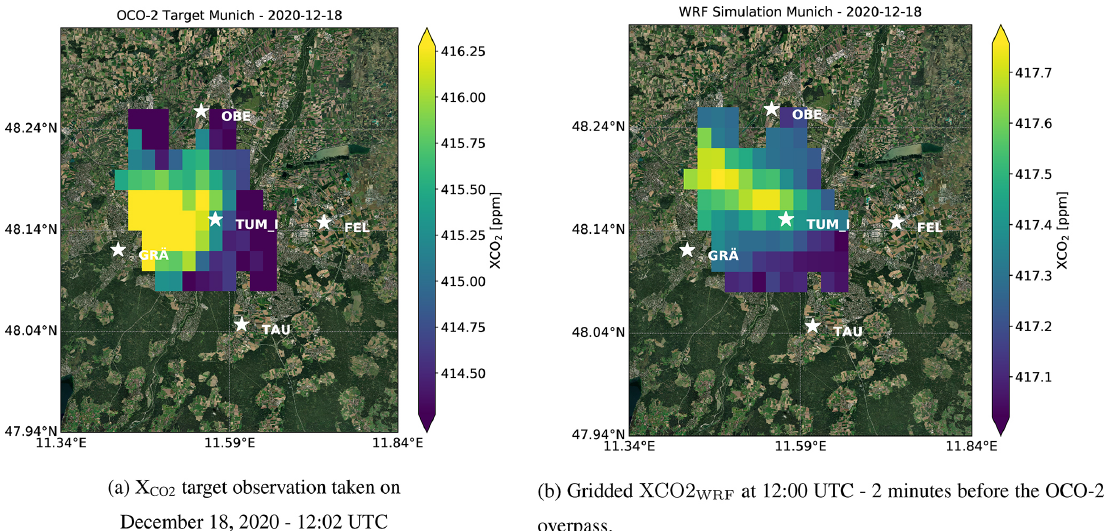
Figure 15. Gridded WRF-GHG outputs and OCO-2 target observation for18 December 2020. Enhanced X CO the center-west of Munich. Map source: Esri, Maxar, Earthstar Geographics, and the GIS User